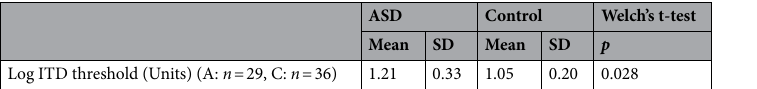
ASD Control Welch’s t-test Mean